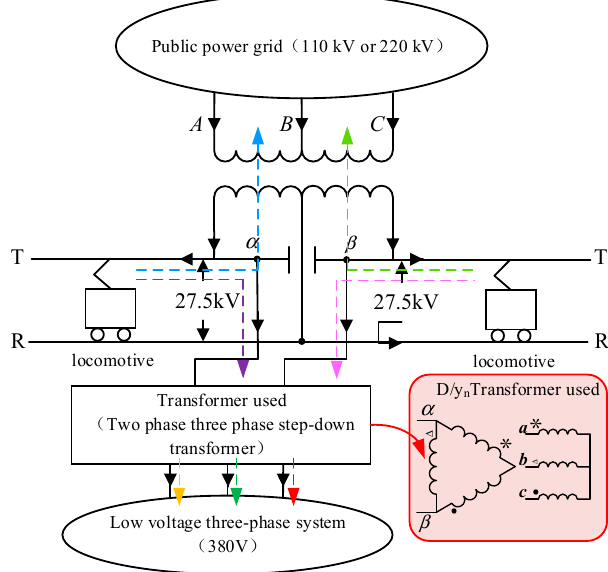
Figure 4. Schematic diagram of a direct-mode V/v traction transformer. When the high-order harmonics are propagating in the longitudinal path, the harmonic current and harmonic voltage relationships between the high and low-voltage levels can be rewritten as: